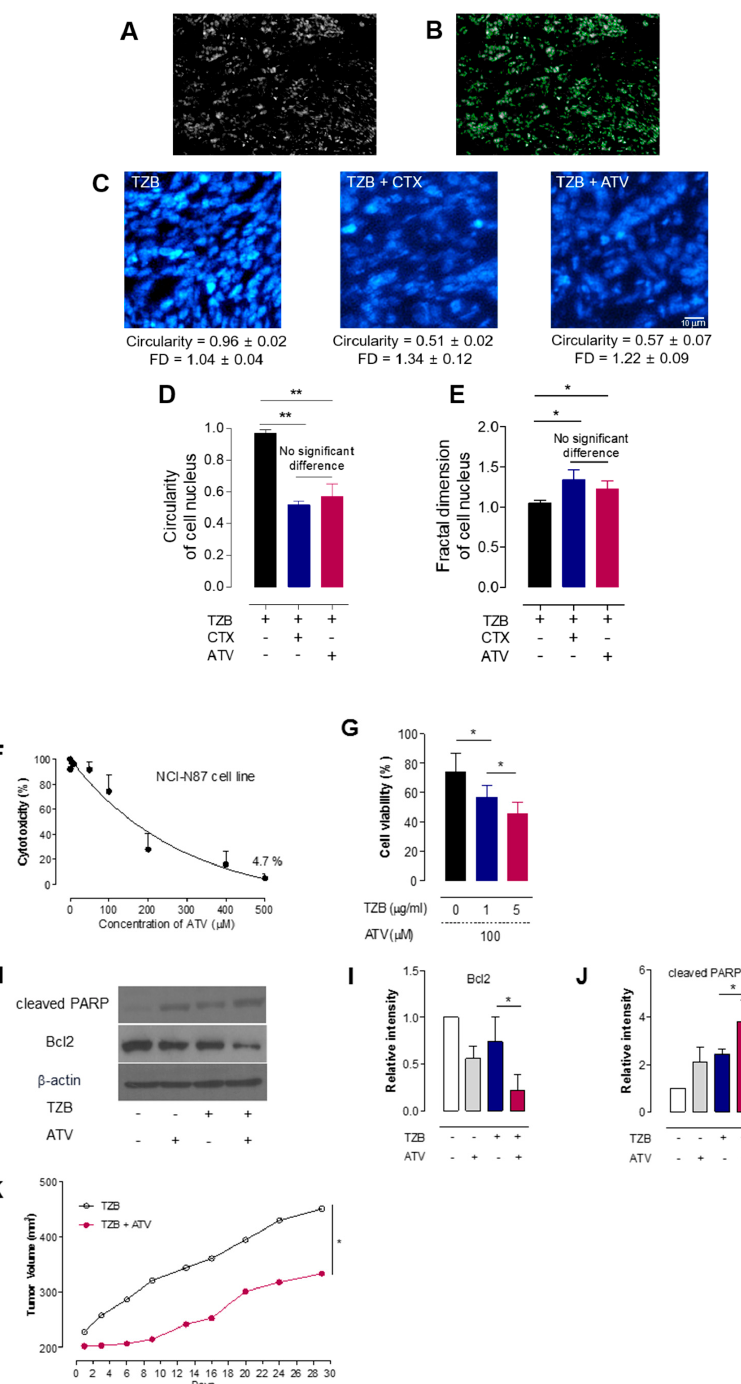
Figure 6. Cytotoxicity of ATV and effect of ATV on apoptosis and tumor growth delay. ( A ) Ex vivo image of cell nuclei. ( B ) The edge contours of DAPI-stained cell nuclei were extracted using a Laplacian edge-finding algorithm. ( C ) Representative images of cell nuclei when CTX or ATV was co-administered with TZB. ( D , E ) Circularity and fractal dimension of the cell nucleus in tumor tissue (mean ± standard deviation) (** p < 0.005 and * p < 0.05). ATV, atorvastatin. TZB, trastuzumab. CTX, cyclophosphamide. FD, fractal dimension. ( F ) Cytotoxicity assay according to the concentration of ATV. ( G ) Cell viability according to the concentration of TZB with ATV (* p < 0.05). ( H ) Cell lysates were immunoblotted with the indicated antibodies. ( I ) Relative intensity of Bcl-2. ( J ) Relative intensity of cleaved PARP. ( n = 3, mean ± standard deviation, * p < 0.05). ( K ) Tumor growth delay for 30 days ( n = 3–5 per group). ATV, atorvastatin. TZB, trastuzumab. PARP, poly (ADP-ribose) polymerase